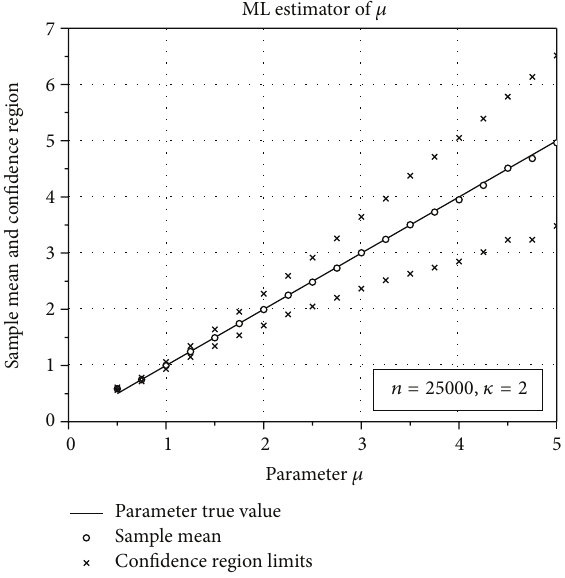
Figure 7: Sample mean and confidence region ( ±2 × sample stan- , for 𝑛 = 25000 and 𝜇 = 1 . dard deviation) of ̂𝜅 ML